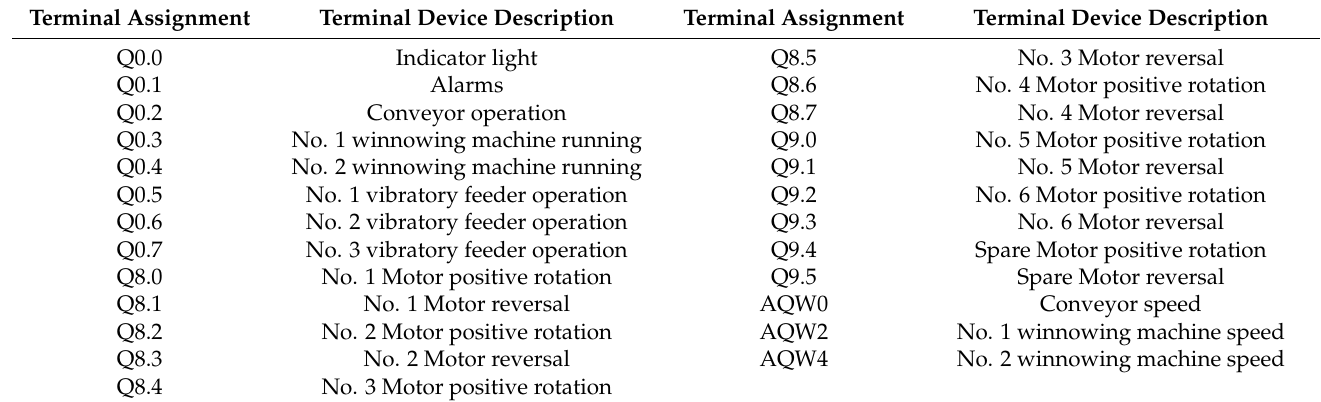
Table 2. Output signal of control